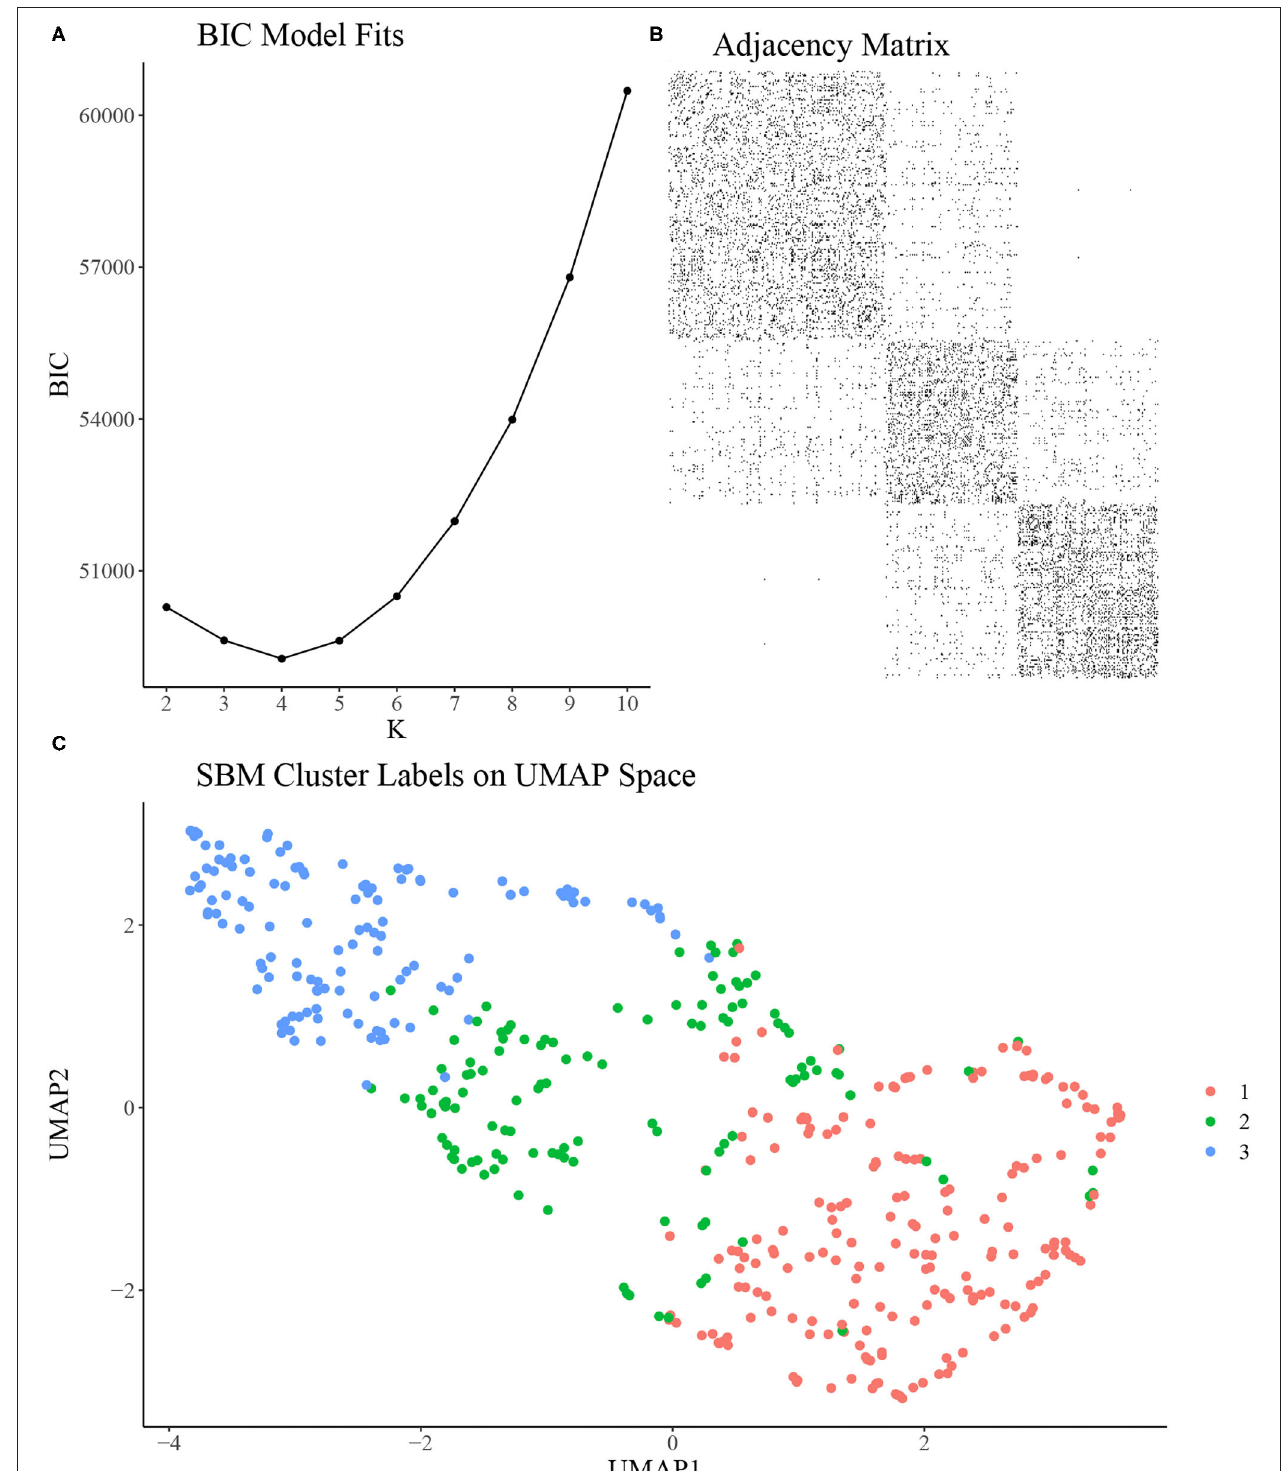
FIGURE 2 | (A) Bayesian Information Criterion (BIC) from SBMs fit with a range of K . K matrix of inferred clusters from the SBM using K K 3 =